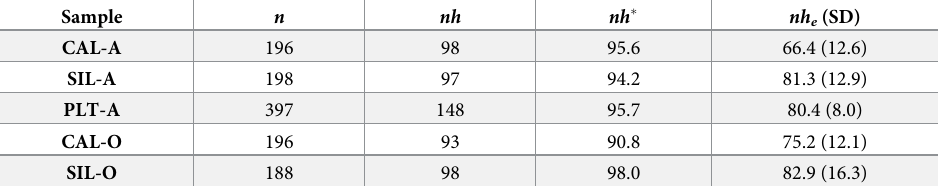
Table 2. Genetic diversity estimates for Pinus sylvestris adult and offspring samples from calcareous and siliceous soils at Sierra de Ayllo´n. Sample n nh nh �